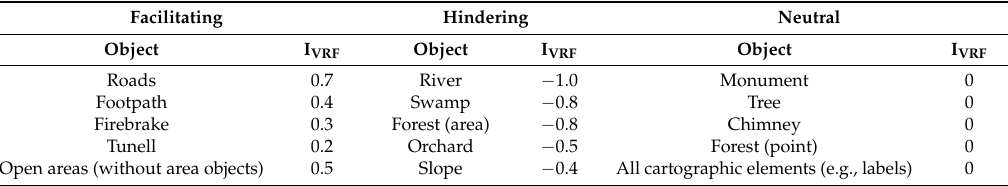
Table 1. Sample vegetation roughness factor (VRF) values.